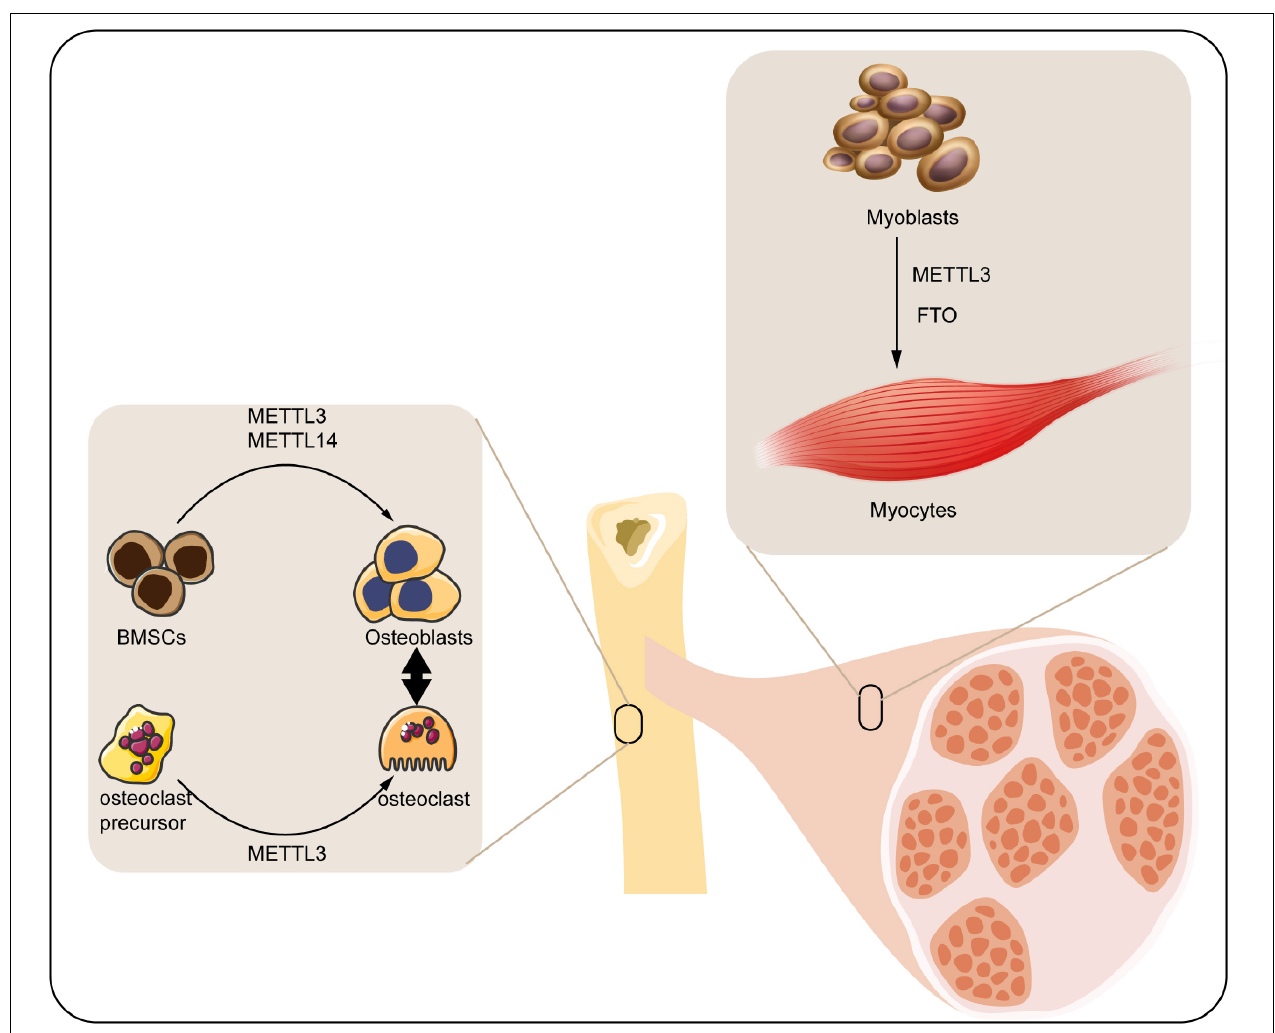
FIGURE 2 | Roles of m 6 A modification in musculoskeletal biology. M 6 A regulatory proteins participate in differentiation of BMSCs, osteoclast precursors, and myoblasts. METTL3, methyltransferase-like 3; METTL14, methyltransferase-like 14; FTO, fat mass and obesity-associated protein; BMSCs, bone marrow mesenchymal stem